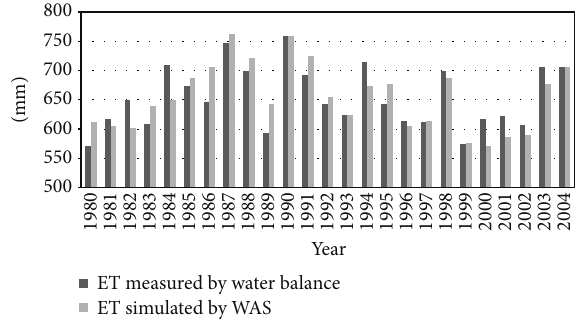
Figure11:ComparisonoftotalETbetweensimulatedandmeasured